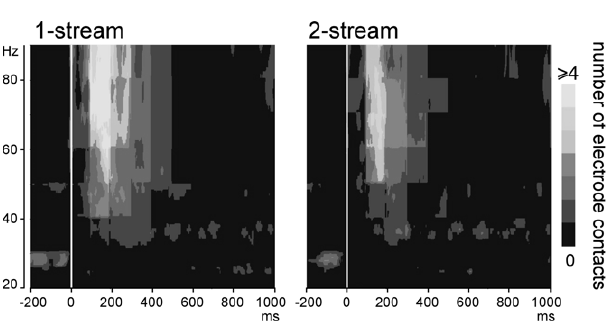
Figure 6. Emergence of induced gamma oscillations after the onset of part 2 (0 ms). Representation, in the time–frequency domain, of the mean number of electrode contacts across patients which presented signifi cantly emerging induced gamma oscillations. By means of a time–frequency cri- teria based on the stimulus phase-locking factor (PLF), only non-phase- locked induced activities are represented here. These activities were most frequently present between 100 and 350 ms in the 50–90 Hz frequency